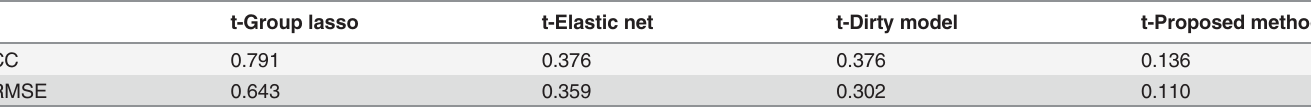
Table 3. The pre fi x ’ t ’ denotes the t-test for CC and RMSE between the methods with age and the corresponding method without using age. t-Group lasso